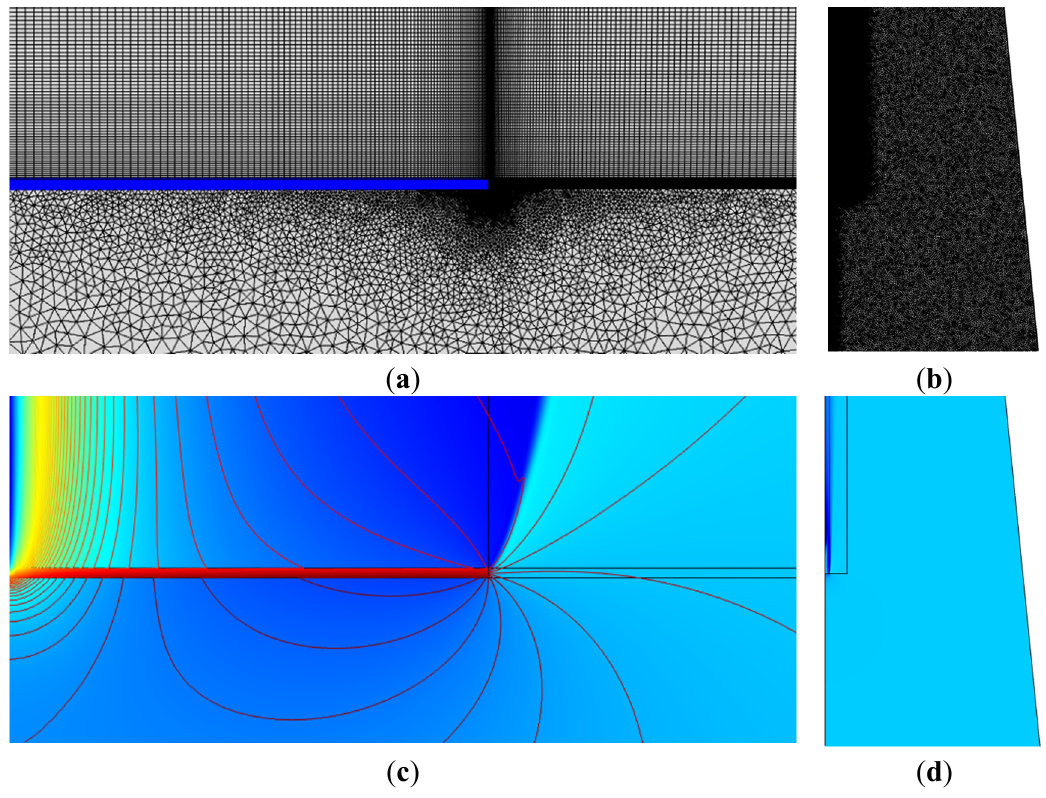
Figure 7. Domain mesh ( a , b ) and example of domain solution with pressure contour lines and axial velocity surface colors ( c , d ). ( a , c ) Disk sub-domain